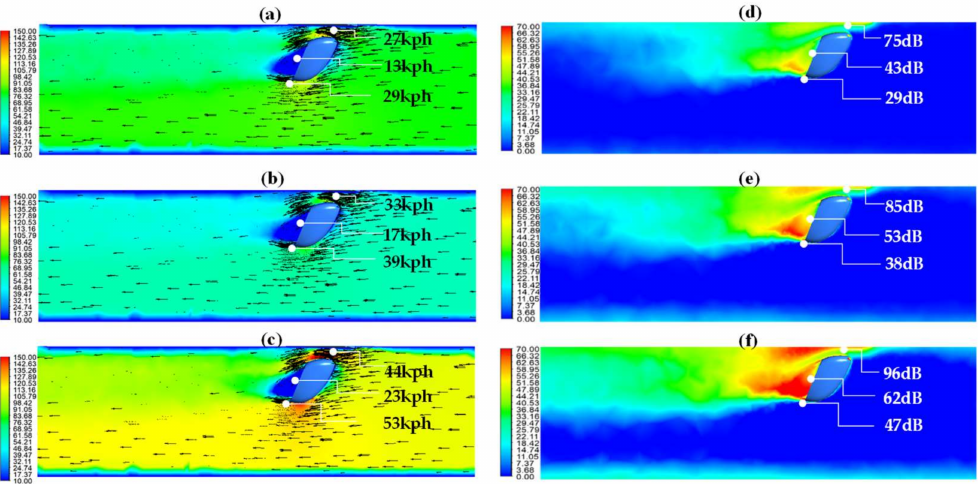
Figure 6. Flow velocity contour with vector field ( a – c ) and maximum sound pressure level ( d – f ) of the third OSRVM model with two inner ducts at 23 ◦ C and 50% humidity condition for three vehicle speeds: ( a , d ) 60 kph, ( b , e ) 80 kph, and ( c , f ) 110 kph.